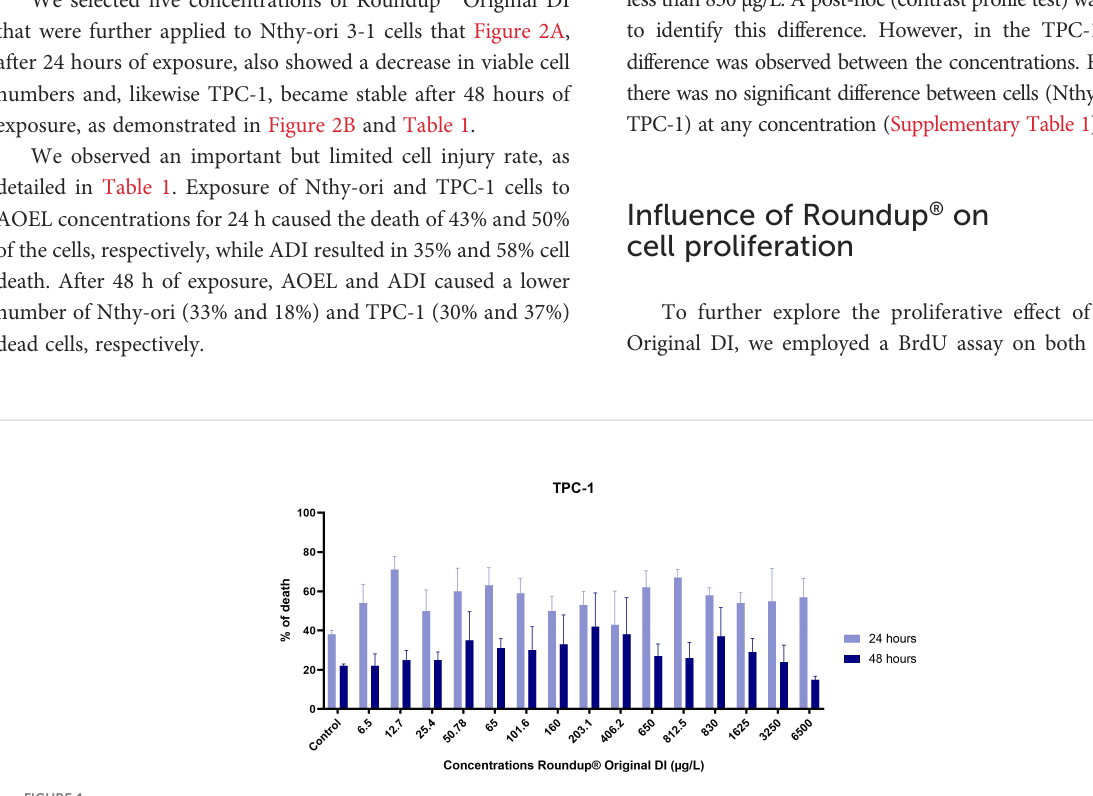
FIGURE 1 Percentage of dead TPC-1 cells after exposure to increasing concentrations of Roundup ® Original DI for 24 h and 48 h measured by the trypan blue dye test. Results are presented as mean ±